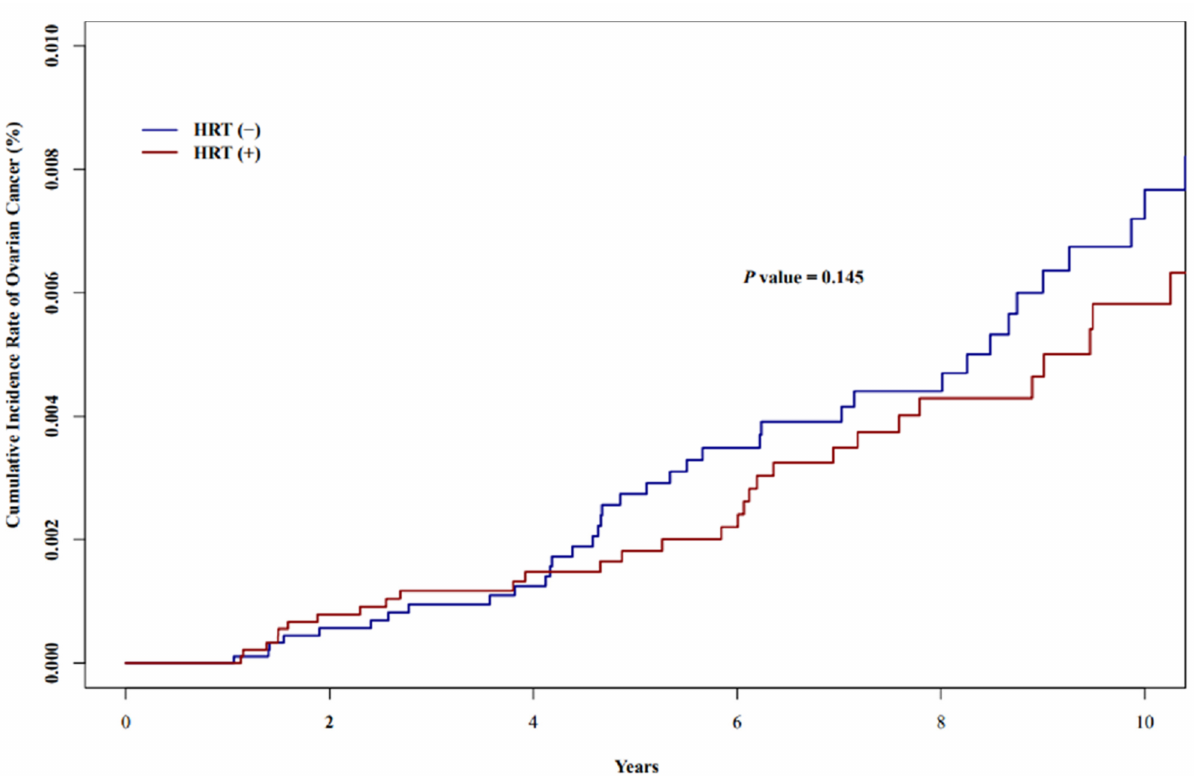
Figure 2. Incidence of ovarian cancer according to HRT in women with endometriosis (HIRA claims data